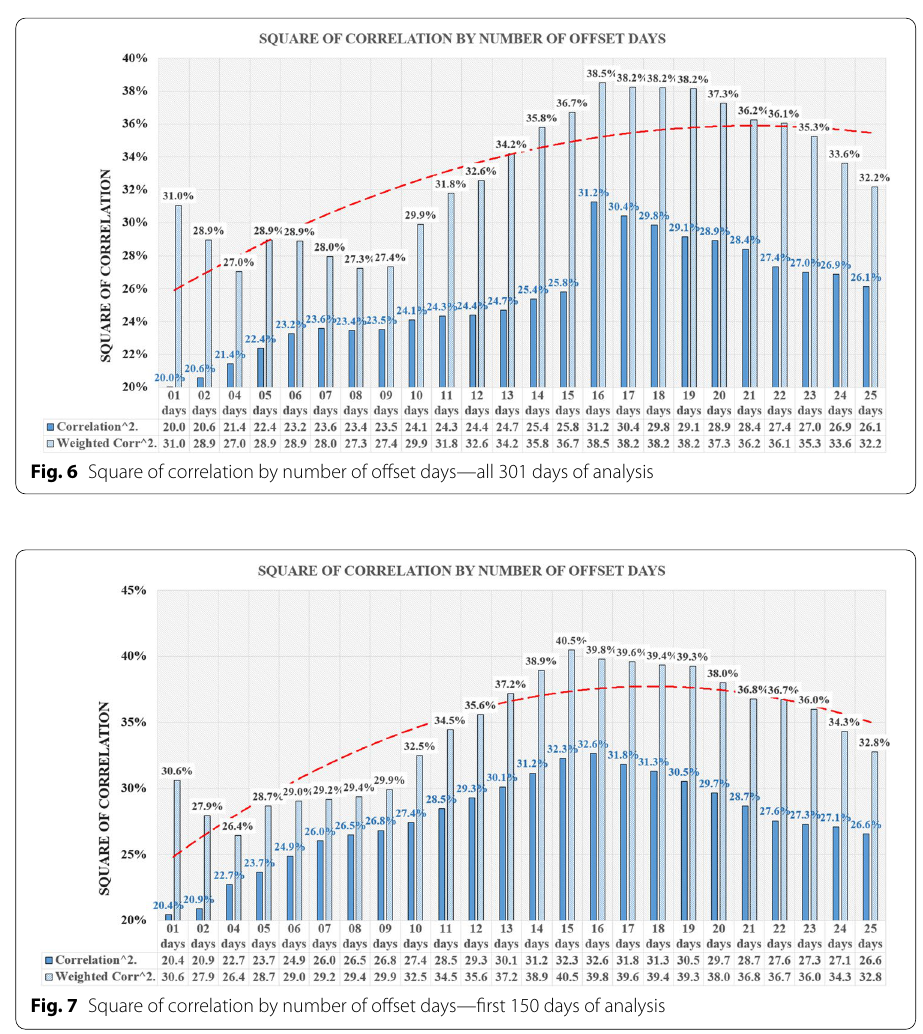
Figure 7 represents the average square of correlation along with the trendline (Polyno- mial: order 2) for the second data collection which included the first 150 days of analy- sis—the spring wave.